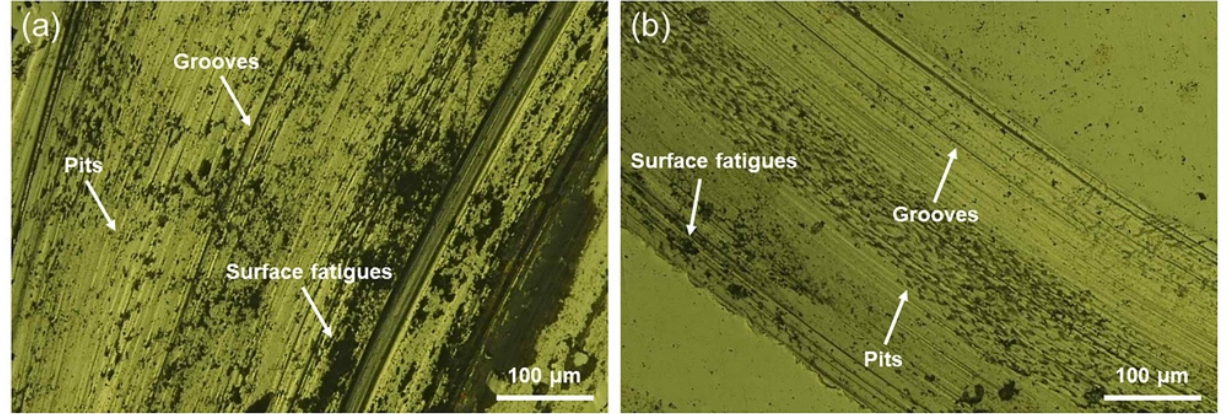
Figure 7. Metallurgical-microscopy images of the wear scars: ( a ) CAST and ( b ) SLM.